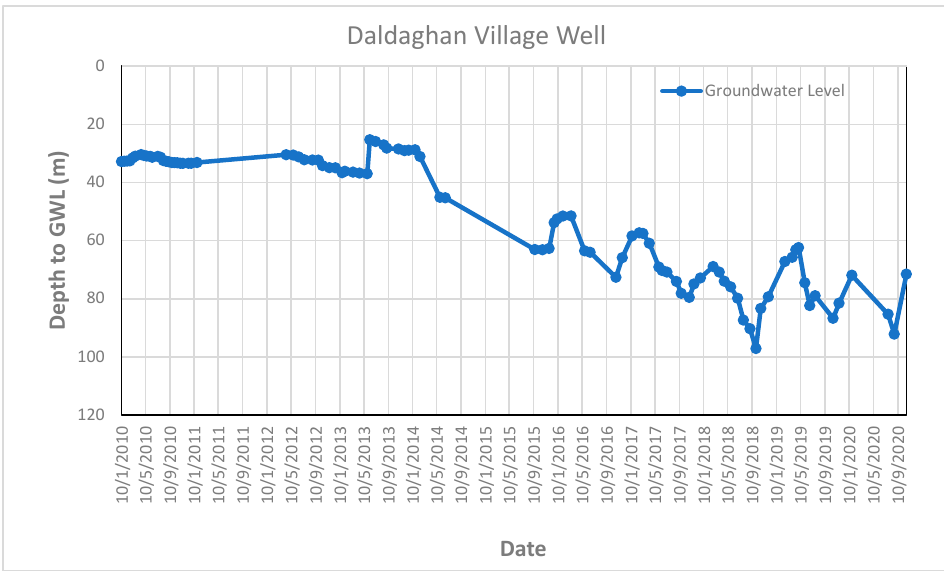
Figure 9. Groundwater level fluctuation curve in Daldaghan Village monitored wells in the study area.